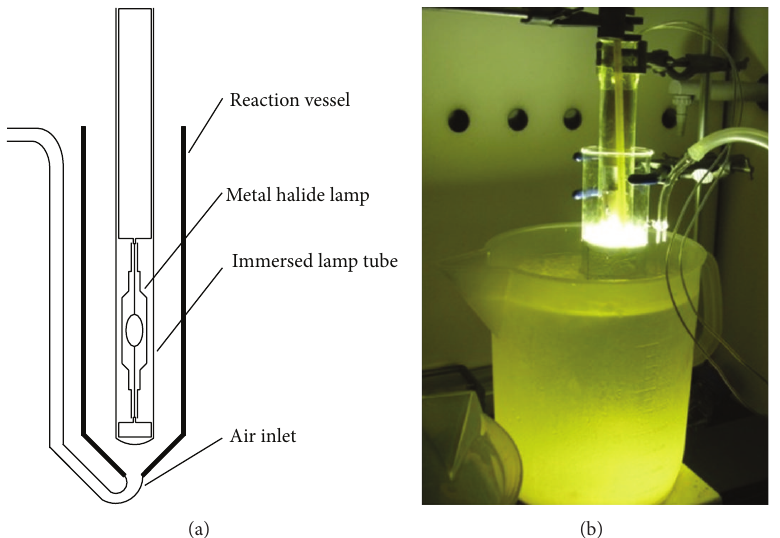
Figure 2: The photoreactor: (a) structure and (b) during photodegradation